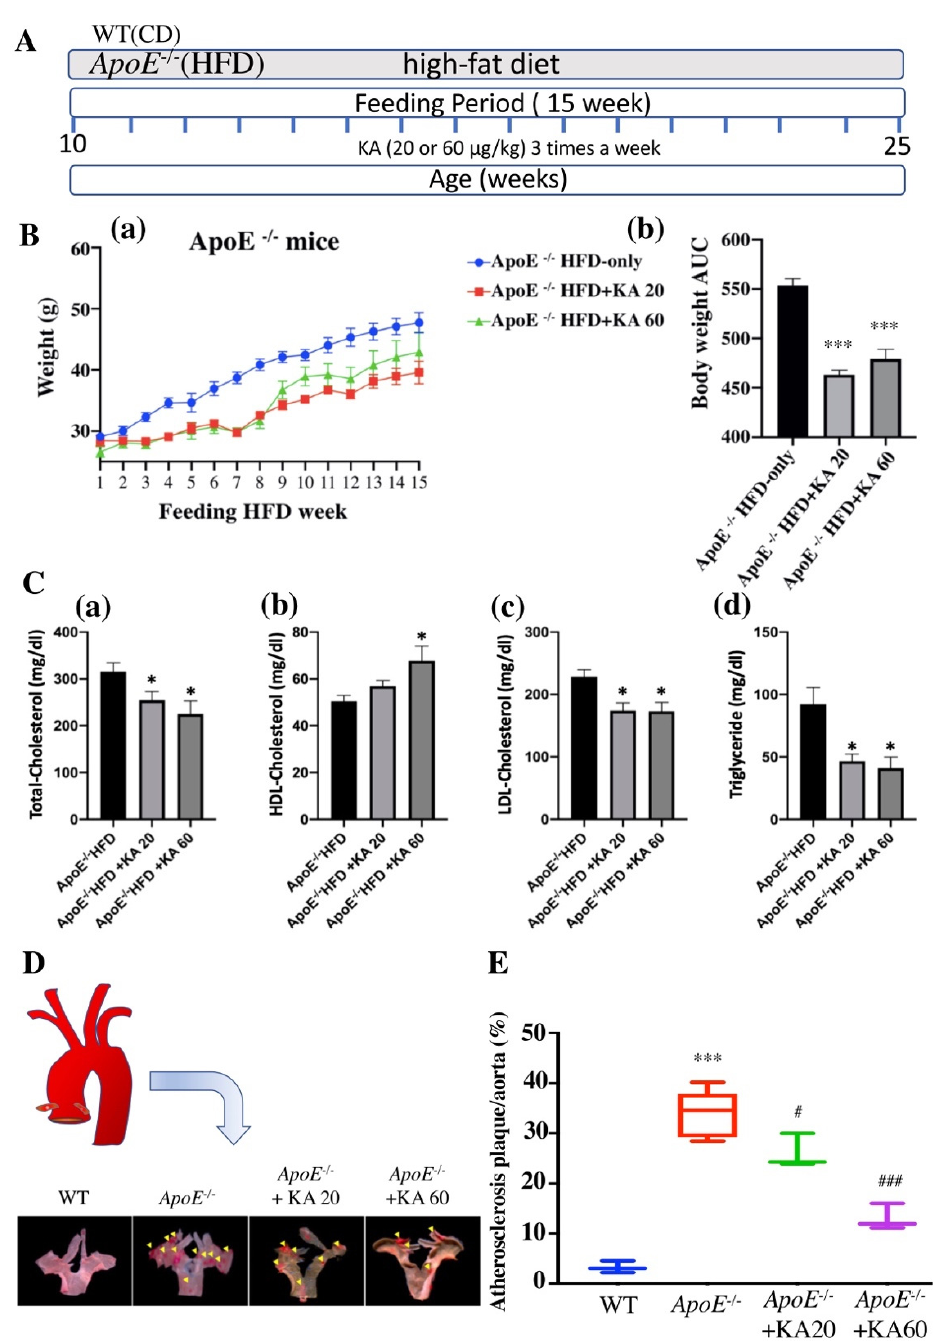
Figure 4. Kansuinine A (KA) reduces atherosclerosis development in ApoE − / − mice. ( A ) Work scheme. Briefly, C57BL/6 (WT) mice received a normal chow diet (CD) or ApoE − / − mice received a high-fat diet (HFD) or ApoE − / − mice received an HFD supplemented with 20 or 60 µ g/kg KA per g of body weight three times a week for 15 weeks. ( B ) Mouse body weight was recorded during the 15 week study period. Body weight curves ( a ) and Area Under the Curve values for body weight (g) ( b ). ApoE − / − mice were fed with a high-fat diet (HFD) or maintained on HFD supplemented with 20 or 60 µ g/kg of KA per g of body weight, three times a week for 15 weeks. Area Under the Curve values for the body weight were monitored each week. All data are presented as the means ± SD; statistical analyses were performed using analysis of variance (one-way ANOVA or the Student’s t -test), n = 5; *** p < 0.001 vs. HFD group. ( C ) Lipid profiles measured at the end of the study period. The plasma lipid profile in ApoE − / − mice fed an HFD or those supplemented with 20 or 60 μ g/kg KA per g of body